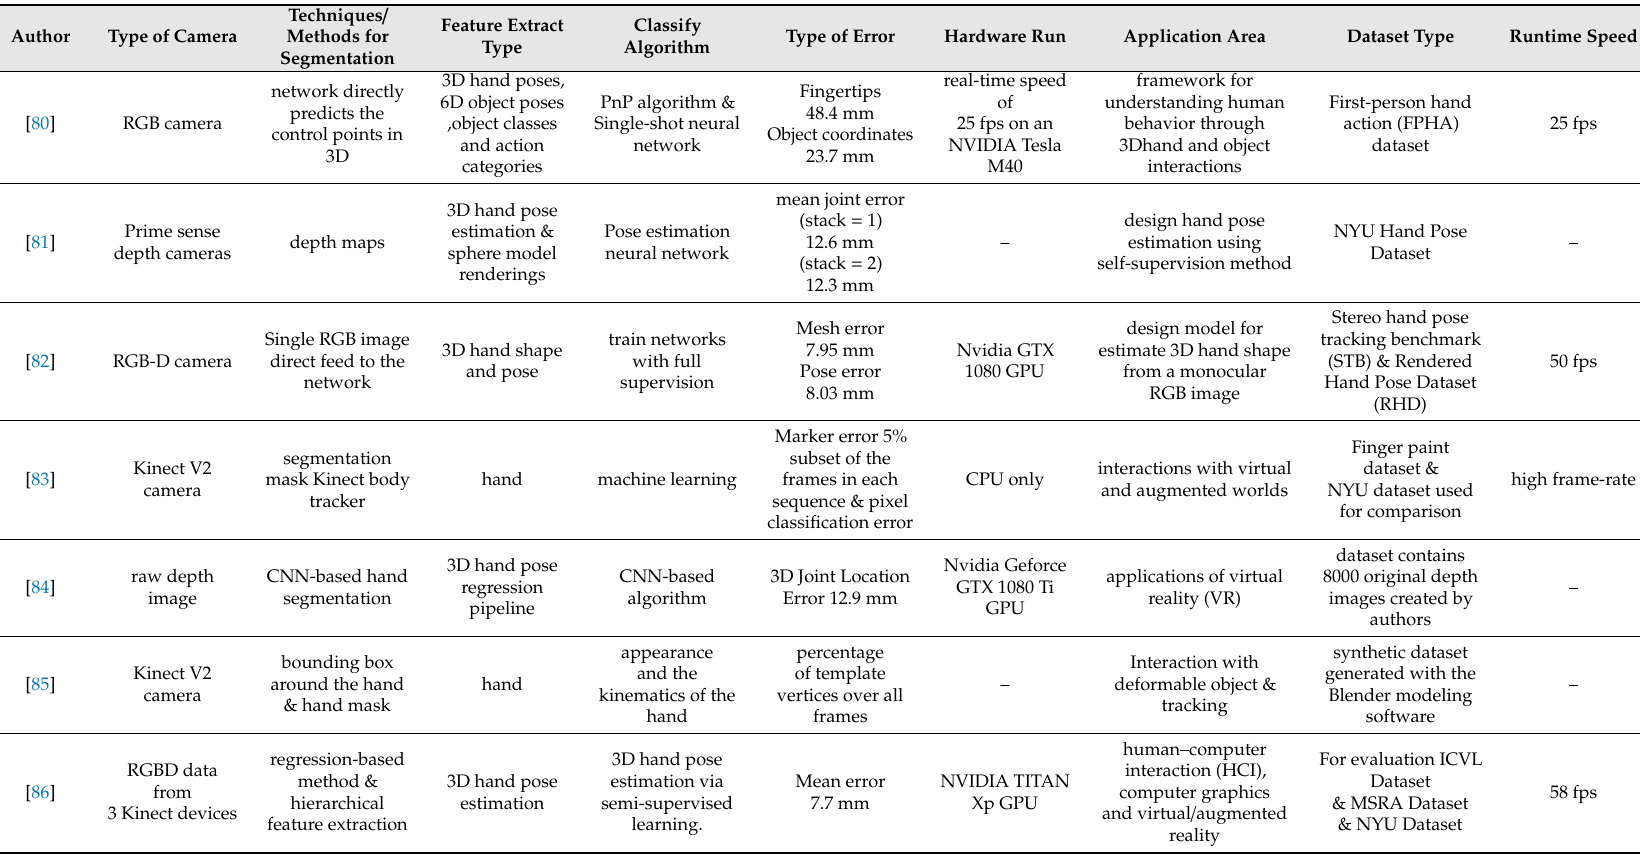
Table 6. Set of research papers that have used 3D model-based recognition for HCI, VR and human behavior